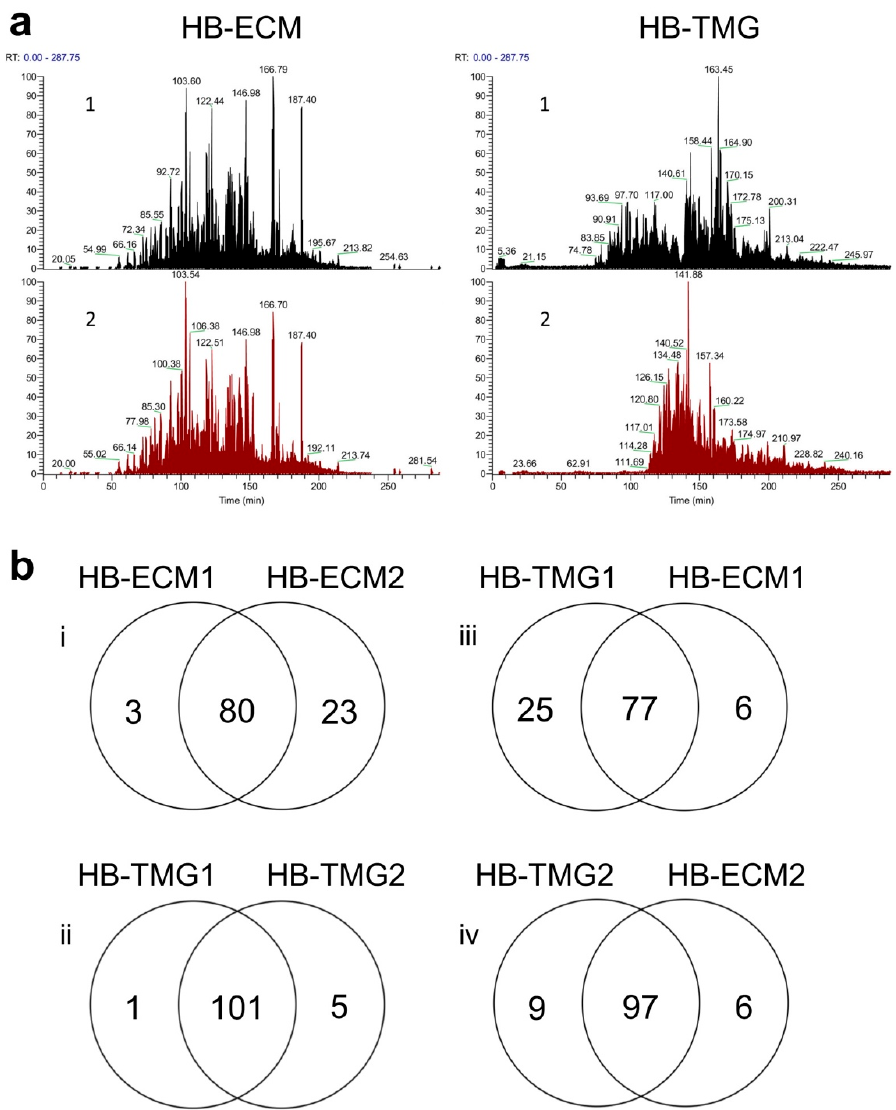
Figure 1. The proteomic compositions of HB-ECM and HB-TMG and acini formation in HB-TMG. Figure 1. Proteomic comparison of HB-ECM and HB-TMG. ( a ) Mass spectrum peaks of the peptides ( a ) Mass spectrum peaks of the peptides corresponding to the identified proteins in HB-ECM and corresponding to the identified proteins in HB-ECM and HB-TMG derived from two patient’s breast HB-TMG derived from two patient’s breast tissues. ( b ) Venn diagrams of the numbers of the com- tissues. ( b ) Venn diagrams of the numbers of the common and the distinct proteins in the HB-ECM mon and the distinct proteins in the HB-ECM and the HB-TMG samples. and the HB-TMG samples.